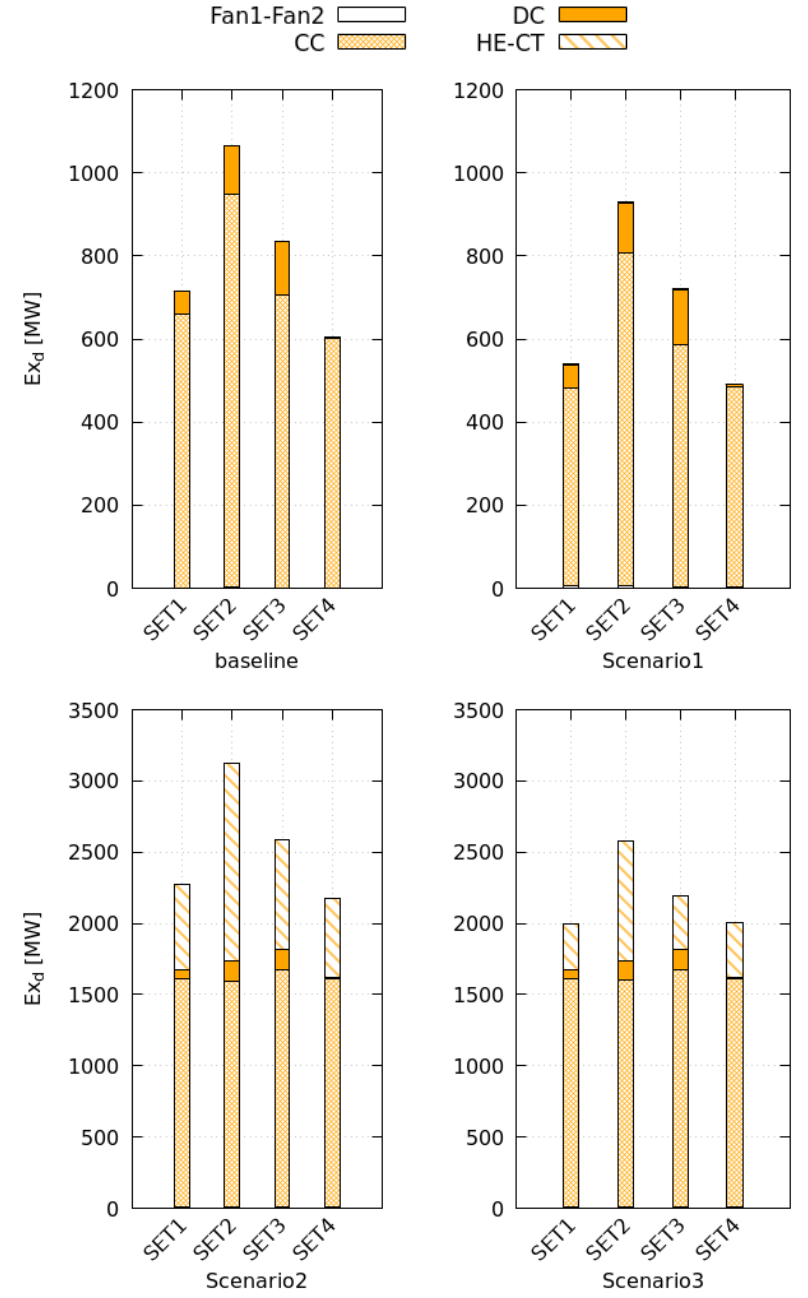
Figure 18. Exergy destroyed in different cycles by flowing (Fan1-Fan2), heating (CC), drying (DC), and heat and mass recovery (HE-CT)